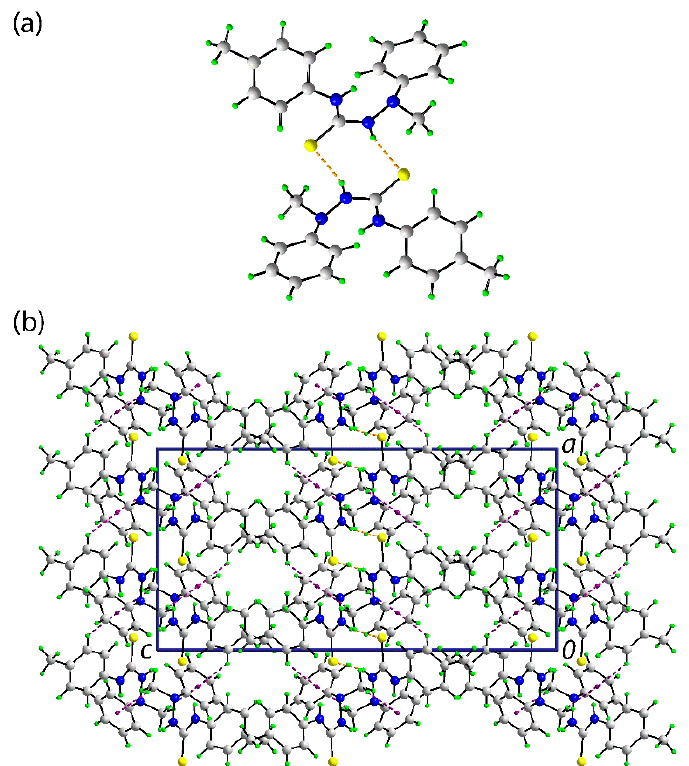
Figure 2. The molecular packing in the crystal of ( 1 ): ( a ) a view of the supramolecular dimer sustained by thioamide–N–H · · · S(thione) hydrogen bonding [N2–H2n · · · S1 i : H2n · · · S1 i = 2.474(14) Å, N2 · · · S1 i = 3.3155(12) Å, angle at H1n = 161.2(12) ◦ for symmetry operation i: 1 − x , 1 − y , 1 − z ] shown as orange dashed lines and ( b ) a view of the unit cell contents shown in projection down the b -axis. The phenyl–